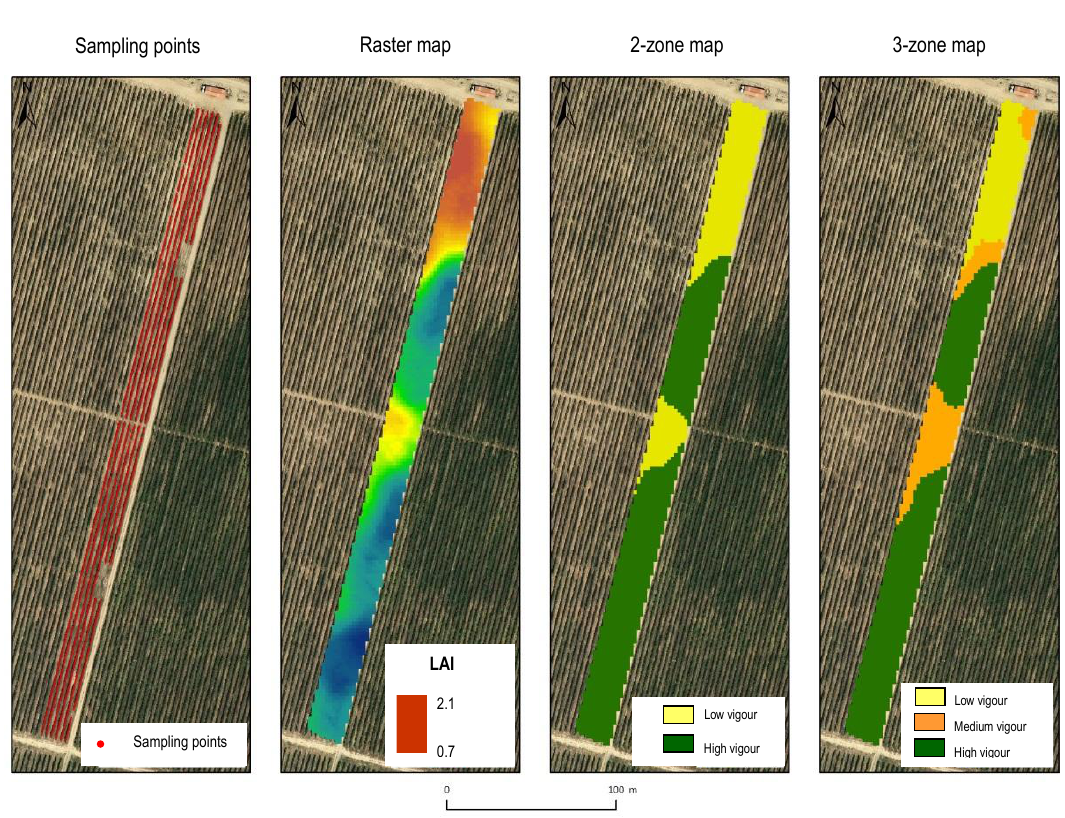
Figure 5. Sampling points, LAI raster map and maps of the LAI